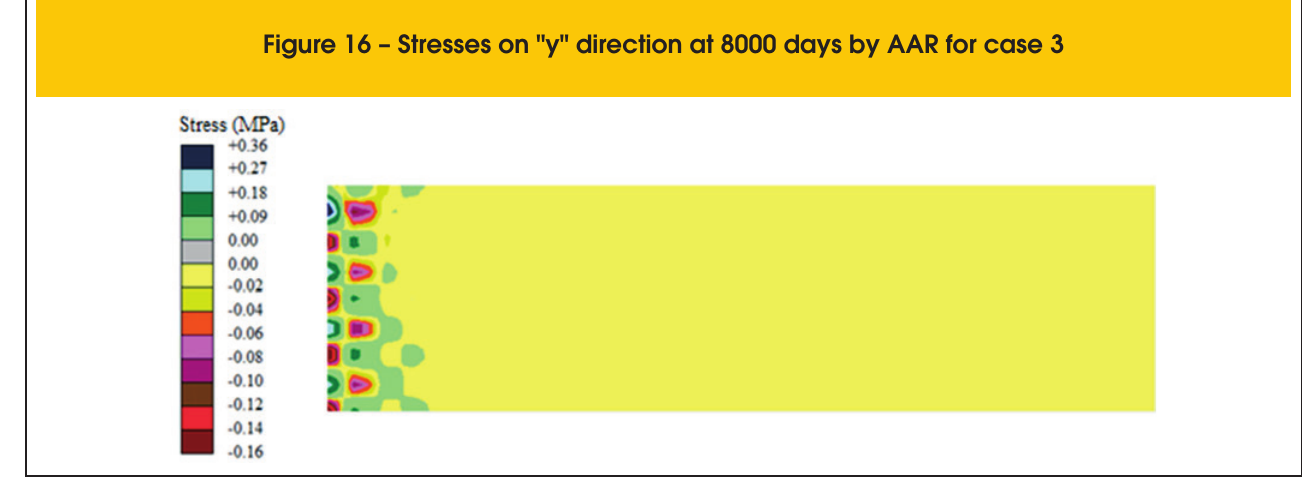
Figure 16 – Stresses on "y" direction at 8000 days by AAR for case